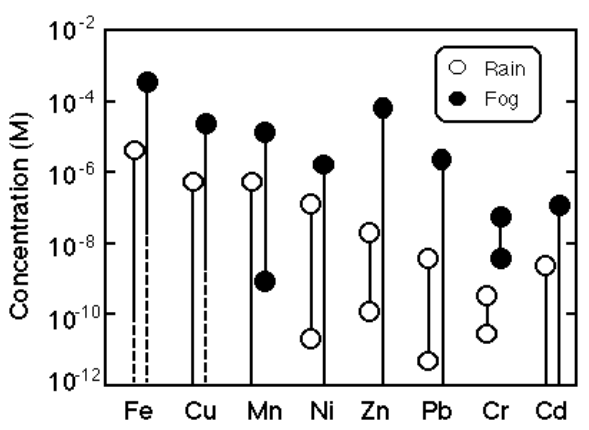
FIGURE 2 . The concentration range of dissolved transition metal ions in rain and fog. Data source: for rain[67,68,69,70,71,72,73,74,75]; for fog[76,77,78,79,80,81]. We also used unpublished data for nickel, zinc, lead, and cadmium in fog water, which was collected in 1998 at the midslope of Mt. Oyama, Japan. The dotted line shows that the concentration is below detection limits, although they depend on the analytical methods. zinc can be present in atmospheric water at submillimolar to millimolar levels at a